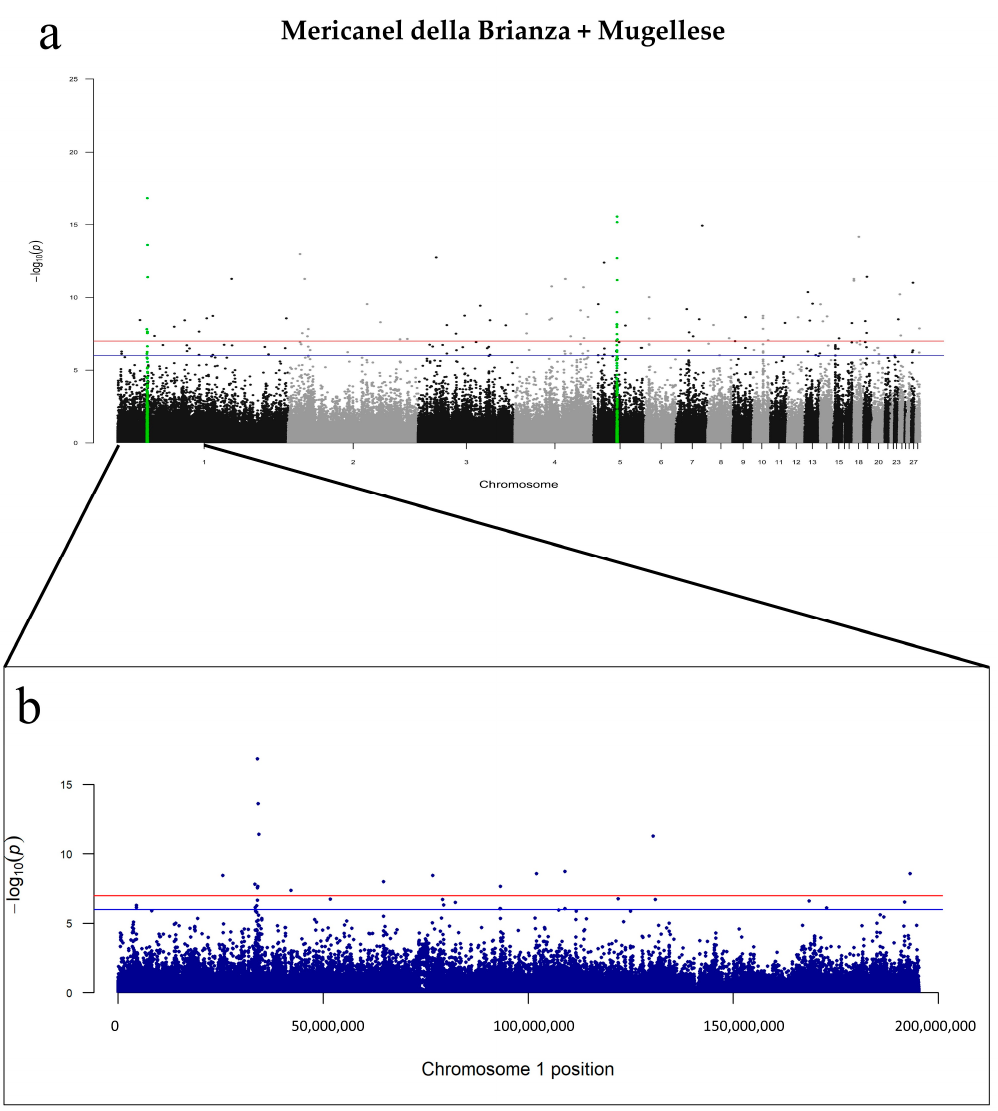
Figure 3. Manhattan plot of ( a ) Mericanel della Brianza + Mugellese breeds tested against the control population and ( b ) details of the chromosome 1 region. The red line represents the p -value < − log10(1 × 10 − 7 ). The blue line represents the suggestive significance, with a value of − log10(1 × 10 − 6 ). Genes of interest such as LEMD3 and HMGA2 were also observed in the meta-anal- ysis. Figure 3b clearly highlights the relevance of GGA1 in the meta-population Mericanel della Brianza + Mugellese (MM) analysis, with significant p -values for the variants associ- ated with the HMGA and LEMD3 genes. Clear implication of these two genes in dwarfism has been widely reported in the literature. In the same above-mentioned genomic region